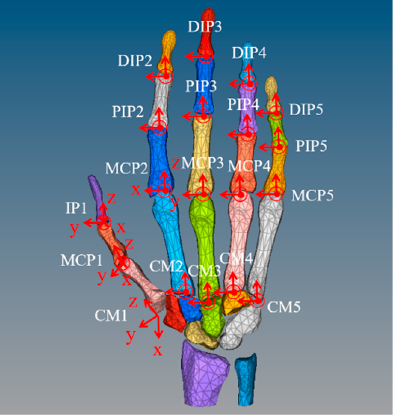
Figure 4. Local coordinate systems constructed at the finger joints of the hand FE